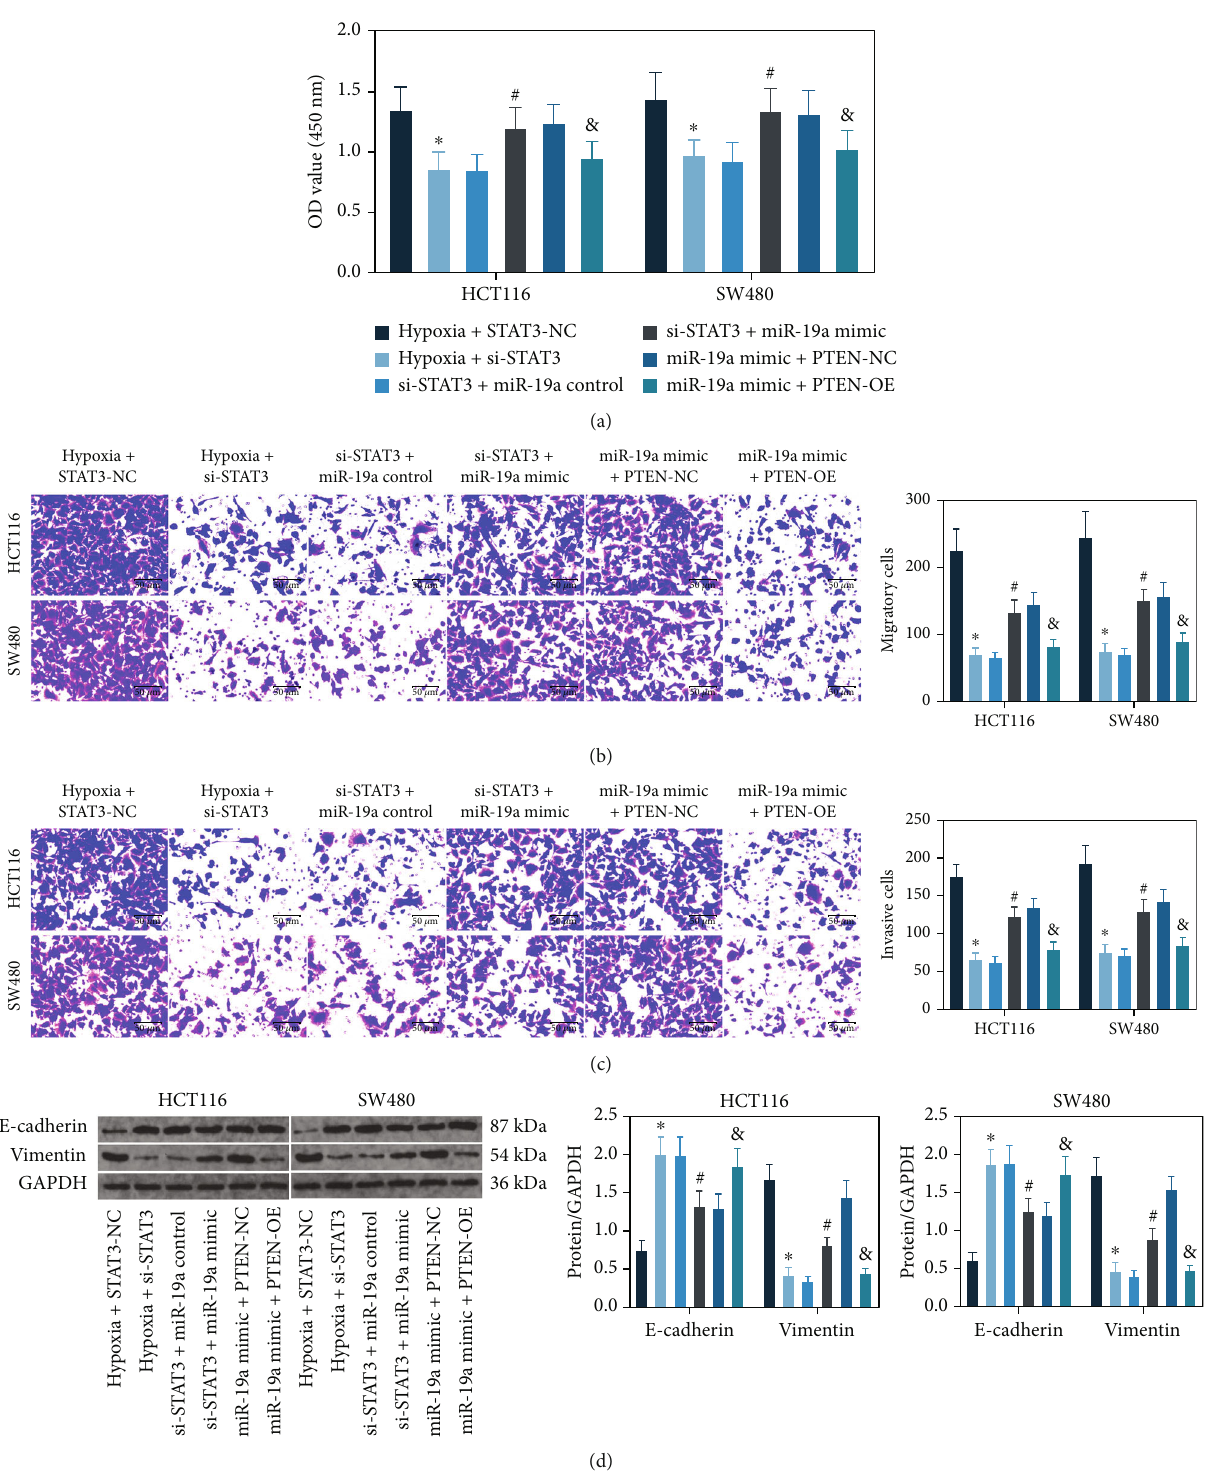
Figure 6: Hypoxia induces the STAT3/miR-19a/PTEN axis to a ff ect activity of the CRC cells: (a) proliferation and viability of cells examined by the CCK-8 assay ( ∗ #& p < 0 : 05 , two-way ANOVA); (b, c) migration (b) and invasion (c) of cells examined by Transwell assays ( ∗ #& p < 0 : 05 , two-way ANOVA); (d) protein levels of E-cadherin and Vimentin in HCT116 and SW480 cells examined by western blot analysis ( ∗ #& p < 0 : 05 , two-way ANOVA). Data were presented as the mean ± SD from three independent experiments. ∗ Compared to the hypoxia + STAT3-NC group; # compared to the si-STAT3 + miR-19a control group; & compared to the miR-19a mimic + PTEN-NC